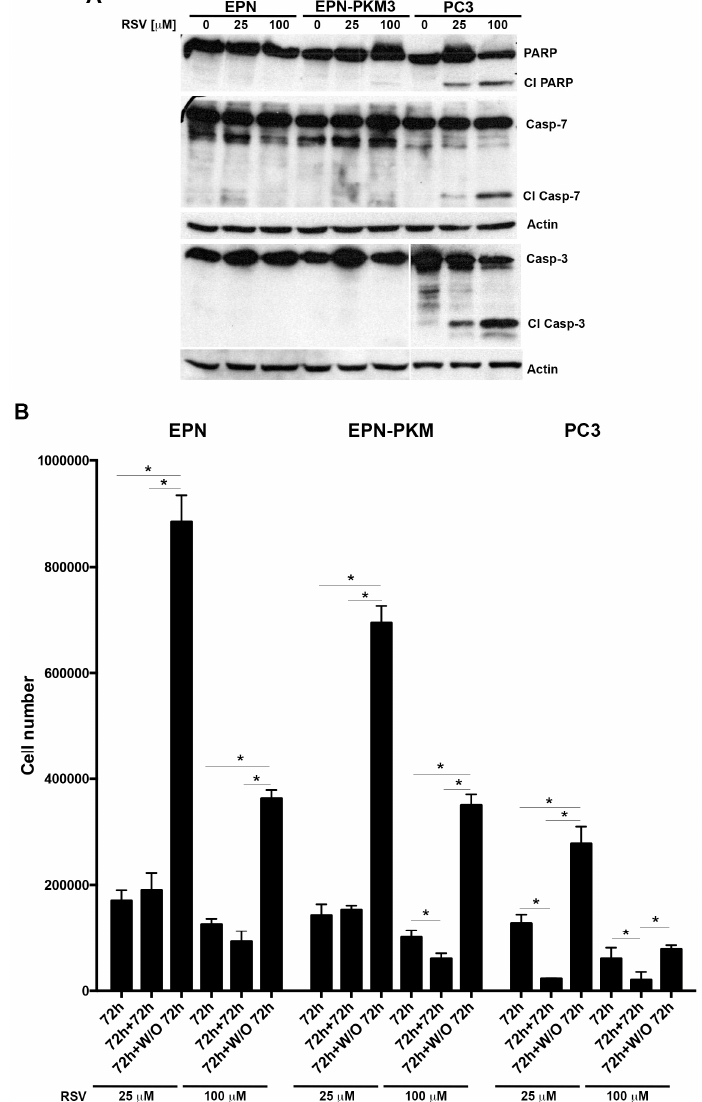
Figure 5. EPN, EPN-PKM and PC3 cells proliferation re-starts upon resveratrol wash-out ( A ) Western blot analysis of the effect of 72 h RSV treatment (25 and 100 μ M) on the expression of native and cleaved form of PARP, caspase-7 and caspase-3 in EPN, EPN-PKM and PC3 cells. Actin was used as loading control; ( B ) RSV (25 and 100 μ M) was added 24 h after seeding 1 × 10 5 EPN, EPN-PKM and PC3 cells in standard medium. After 72 h, medium was replaced with RSV-containing medium in a group of dishes and with standard medium in another one. Cell number was determined in a Neubauer hemocytometer after 72 h of treatment (72 h), 144 h of treatment (72 h + 72 h) and 72 h of treatment followed by 72 h of W/O (72 h + W/O 72 h). Data are mean ± SD of a representative experiment performed in triplicate. (*) indicates statistically significant differences ( p < 0.05) between each pair of experimental points connected by the horizontal bar.